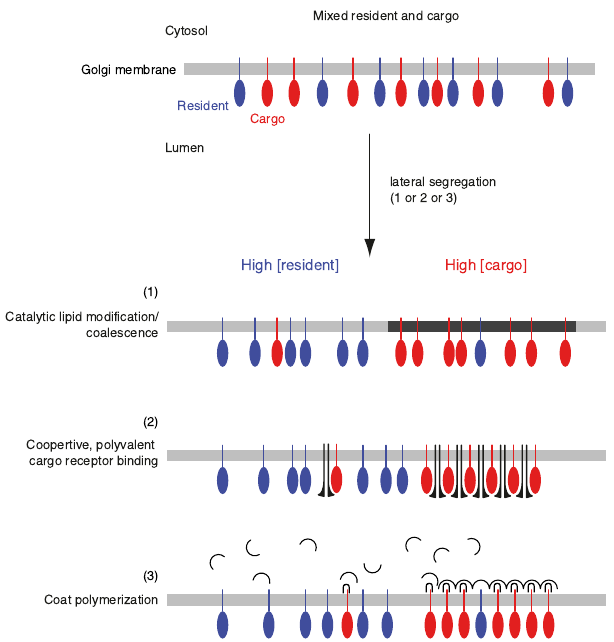
Figure 8 Possible mechanisms of lateral segregation Three non-exclusive processes are proposed to explain rapid spatial partitioning of transmembrane cargo from Golgi resident protein. All rely on enzymatic or cooperative processes to quickly generate a region of high cargo concentration. (1) Golgi associated lipid-modifying enzymes [48–50] catalytically contribute to the generation of a region with distinct lipid composition, to which transmembrane cargo (or certain classes of cargo) preferentially partition. (2) A multimeric or multivalent cargo receptor binds to cargo, causing it to clus- ter in the plane of the membrane. Polyvalent binding mecha- nisms have been shown to induce domains on the plasma membrane which are large enough to visualize with fluores- cence microscopy [51]. Coöperative binding could very rap- idly generate a region of high cargo concentration. A good candidate for a cargo receptor would be a lectin which only binds after specific glycosylation events are completed [52,53]. (3) Cytosolic coat proteins interact with signals in the tail of certain classes of cargo, perhaps via an adaptor ( ∩ , [13]). Polymerization of the coat would rapidly cluster cargo into a coated region of the Golgi; such a mechanism is con- sistent with the several types of coated membranes on Golgi stacks observed by EM [1,28]. Here, coat proteins are shown interacting with cargo, which would be consistent with the lower mobility of cargo in Golgi membranes compared to resident protein, but different coat proteins could also inter- act with Golgi resident proteins to sequester them away from cargo. For simplicity of presentation, they are consid- ered separately, but we envision that par titioning of resident protein from cargo is most likely achieved by these mecha- nisms acting in